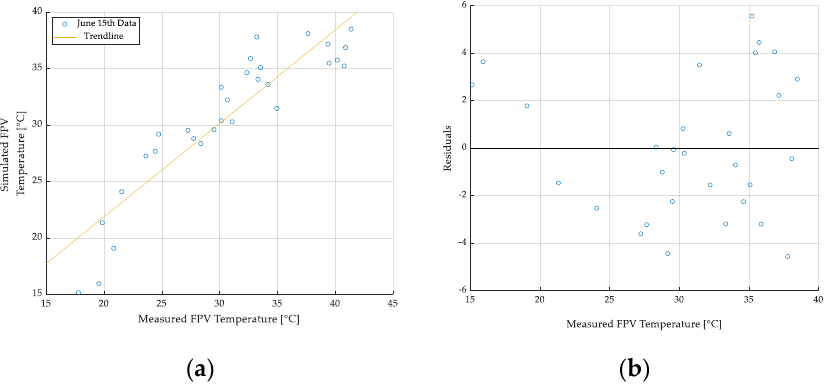
Figure 5. Multilinear regression results of the FPV panels’ effective operating temperature (T eo ): ( a ) simulated FPV temperature plotted against the measured temperature for 15 June 2020; ( b ) residuals’ distribution plotted against the simulated FPV temperature for 15 June 2020.